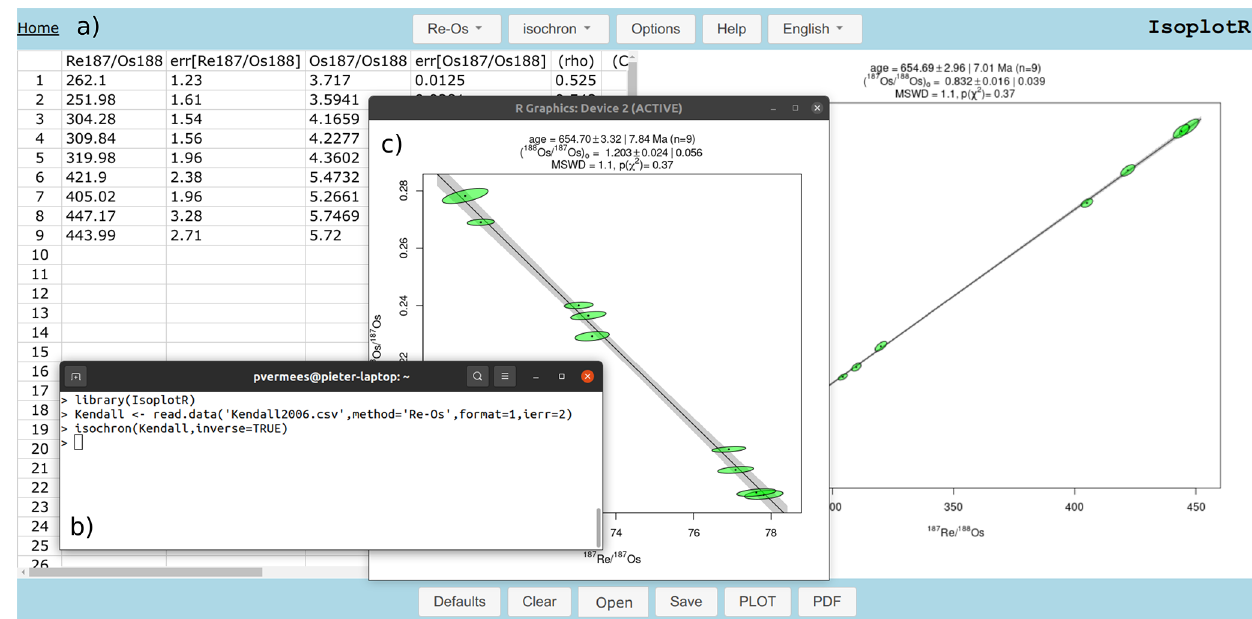
Figure 3. Conventional and inverse isochrons can be constructed with IsoplotR , (a) either using its graphical user interface (b, c) or from the R command prompt. This is illustrated here for a Re–Os dataset of Kendall et al. (2006) that exhibits weaker error correlations than the example of Fig. 1. The normal (a) and inverse (c) isochrons produce nearly identical